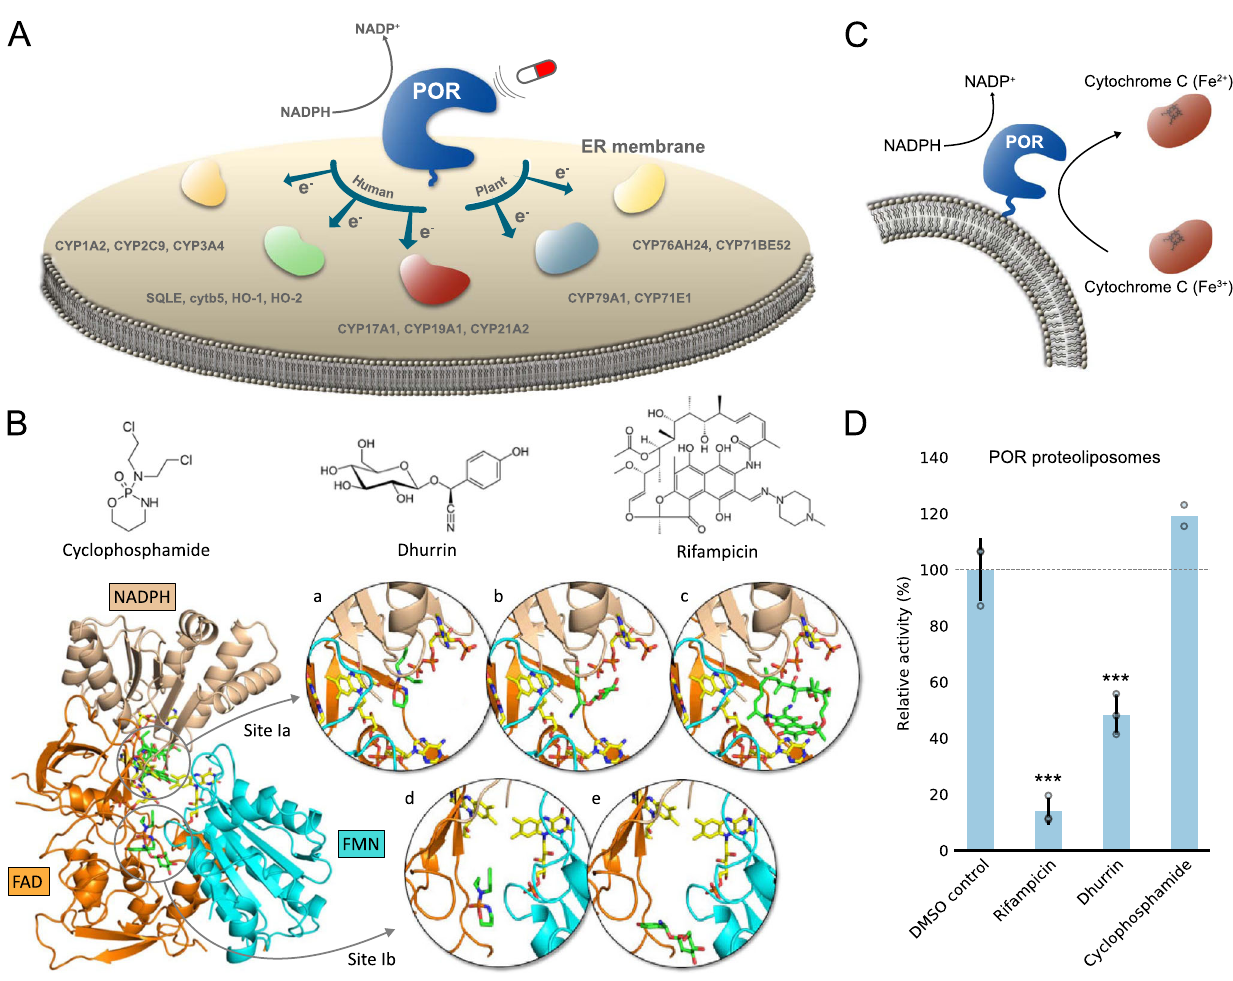
Fig. 1 Small molecules dock on human POR and regulate electron transfer in vitro. A POR is the omnipotent electron donor to all CYPs in the ER membrane, activating metabolic cascades in both human and plants by transferring electrons to redox partners. Targeting POR with small-molecule ligands may bias metabolic outcomes and regulate basic metabolism in humans or tune the formation of natural products in plants. B Molecular structures of small-molecule ligands and their respective binding. Ligands (green) were docked on human POR with cofactors (yellow) in a compact conformation (PDB 3QE2) in Sites Ia and Ib determined from SiteMap analysis (see Supplementary Fig. 3A and Supplementary Table 1). Insets display the predicted binding conformations of cyclophosphamide (a + d), dhurrin (b + e), and rifampicin (c). See Supplementary Figs. 3 – 5 for higher magni fi cation and detailed interactions and Supplementary Table 2 for binding energies. C In vitro activity of human POR proteoliposomes measured by the commonly used Cyt c assay 29 . D Ligands bias human POR capacity to reduce Cyt c in proteoliposomes at 100 μ M, acting either as agonist (cyclophosphamide) or inverse agonizts (dhurrin and rifampicin). The bar plot represents the mean ± SD of independent replicates ( n = 2 – 3; see Supplementary Table 3 for exact value of n for each experimental condition). Overlapping data points appear shaded. Level of signi fi cance is determined by one-way ANOVA and Tukey ’ s HSD test correcting for multiple comparisons (* p < 0.05; ** p < 0.01; *** p < 0.005; see Supplementary Methods and Supplementary Table 3 for details). Source data are provided as a Source Data fi